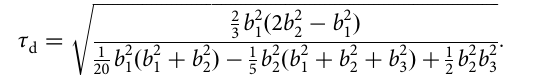
rate are shown in panels c and d, respectively. Hamiltonians